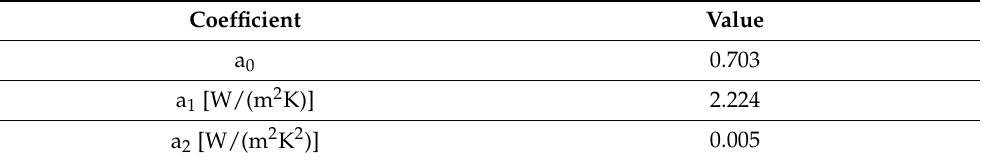
Table A1. Coefficients of the solar gain equation for the AKOTEC